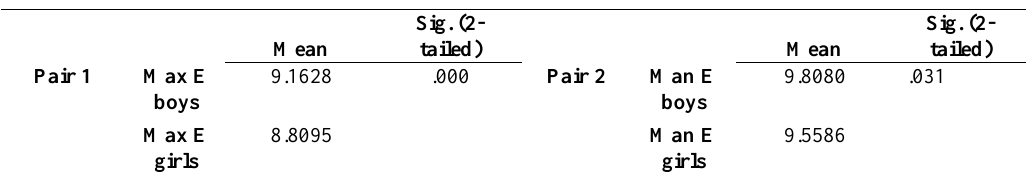
Table 2: Comparison between the mean MD values of the maxillary and the mandibular second primary molars between both